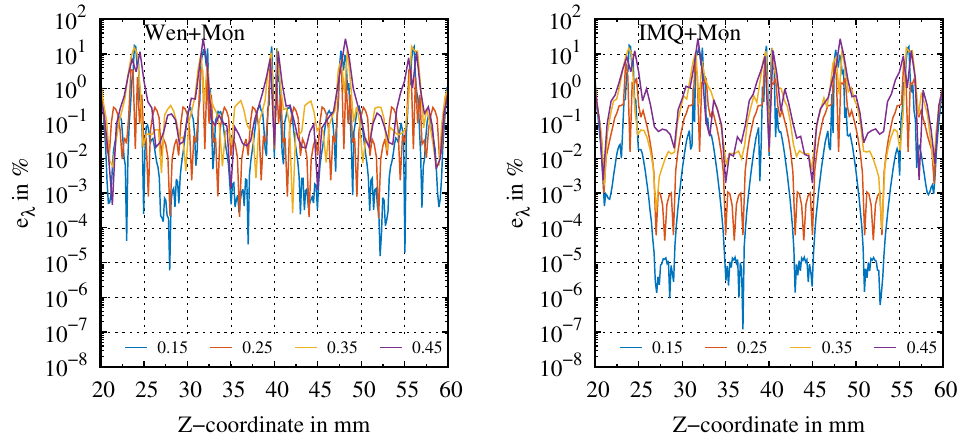
Figure 9. Rough surface verification example for different point distances ∆ d = ( 0.15,0.25,0.35,0.45 ) in mm and adapted shape parameters: ( left ) Wendland function with monomials ( R 0 = 10 ∆ d ), ( right ) inverse multi-quadrics with monomials (ˆ c IMQ ( ∆ d ) in Equation